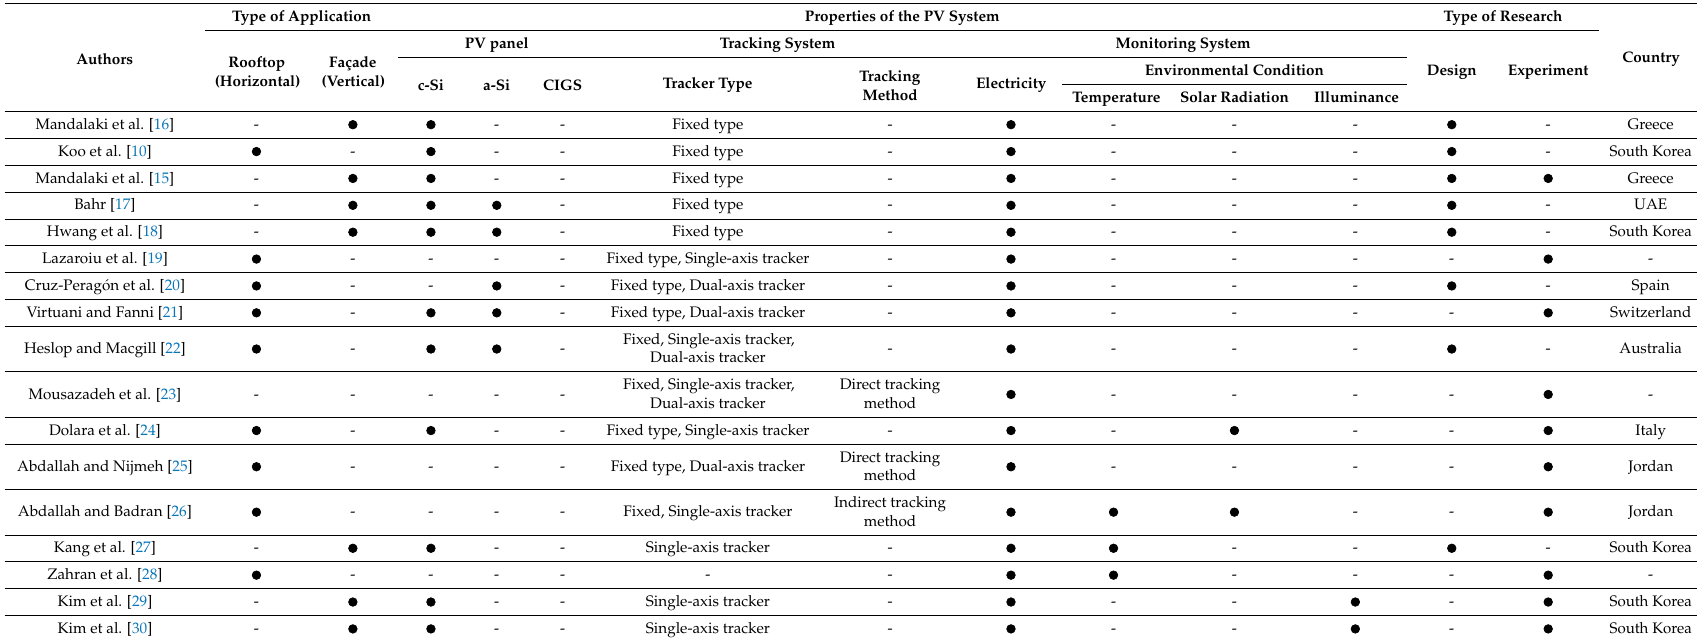
Table 1. Literature review on the PV